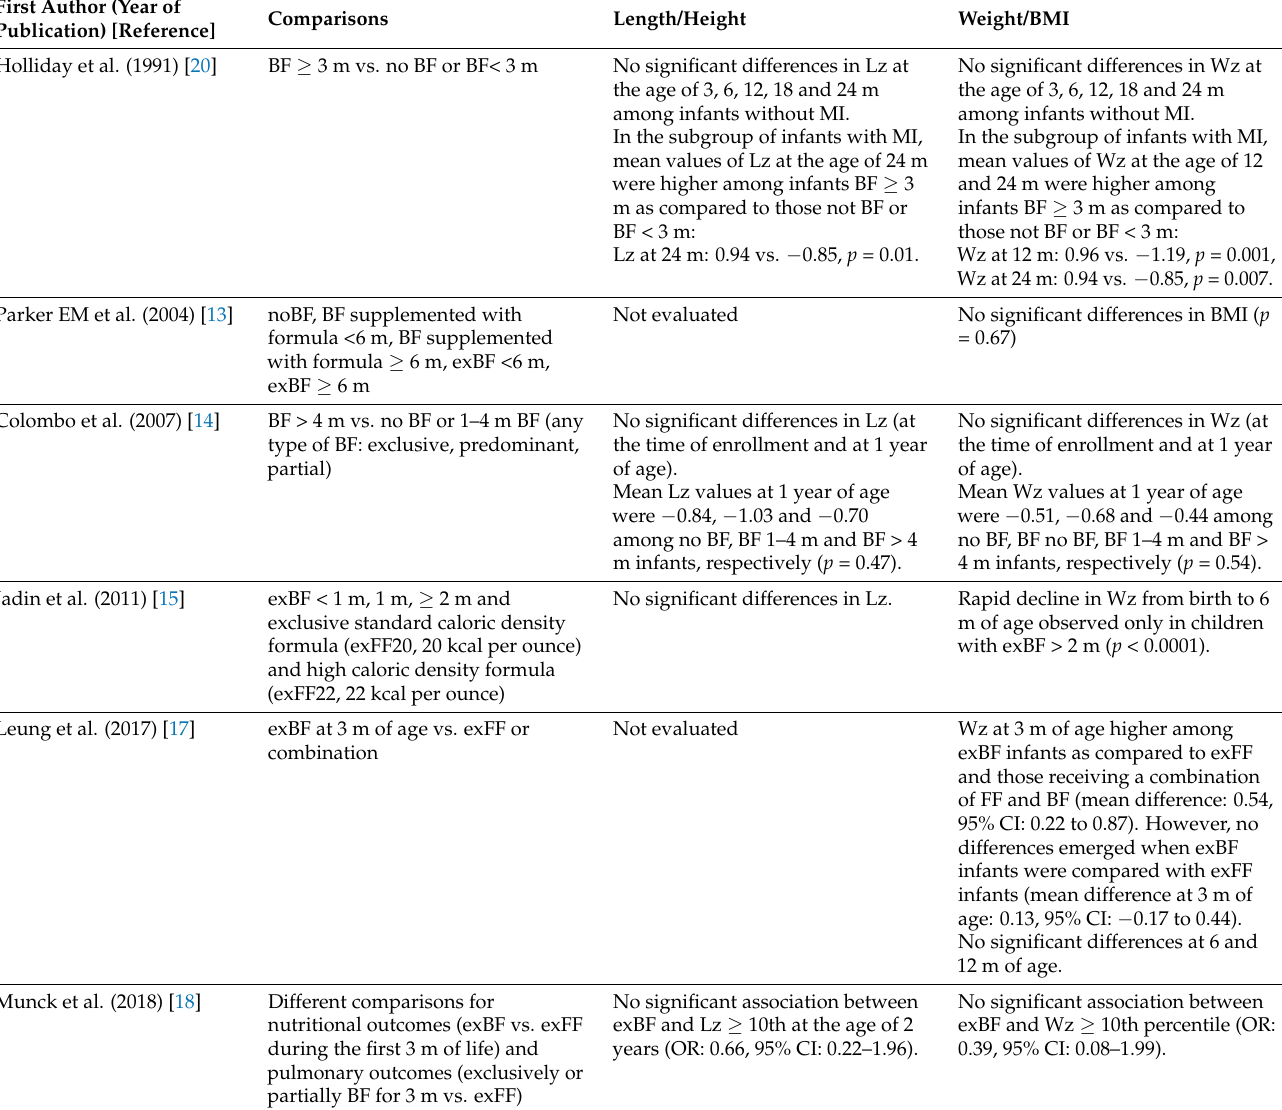
Table 4. Summary overview of the studies evaluating the association between breastfeeding and anthropometric outcomes in cystic